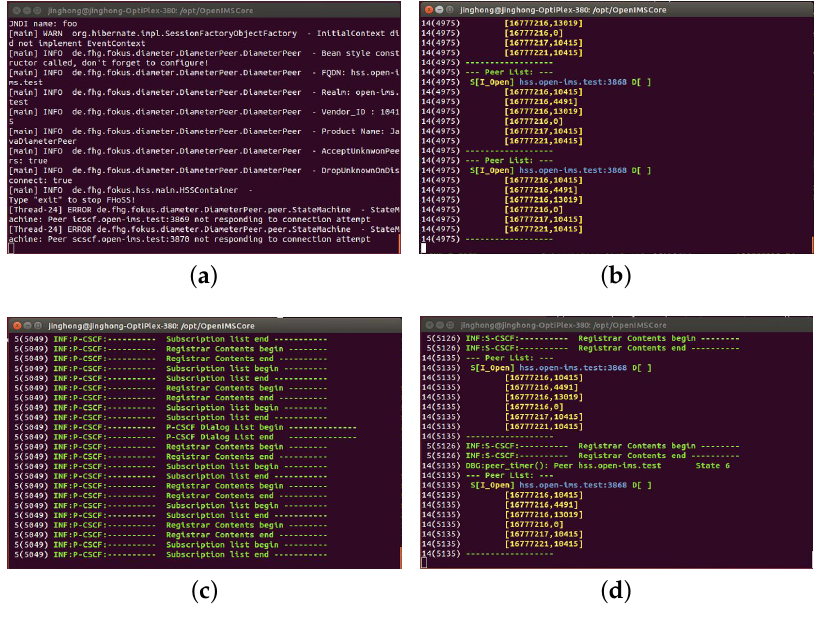
Figure 9. Practical implementation of each IMS unit: ( a ) HSS; ( b ) I-CSCF; ( c ) P-CSCF, and ( d ) S-CSCF.